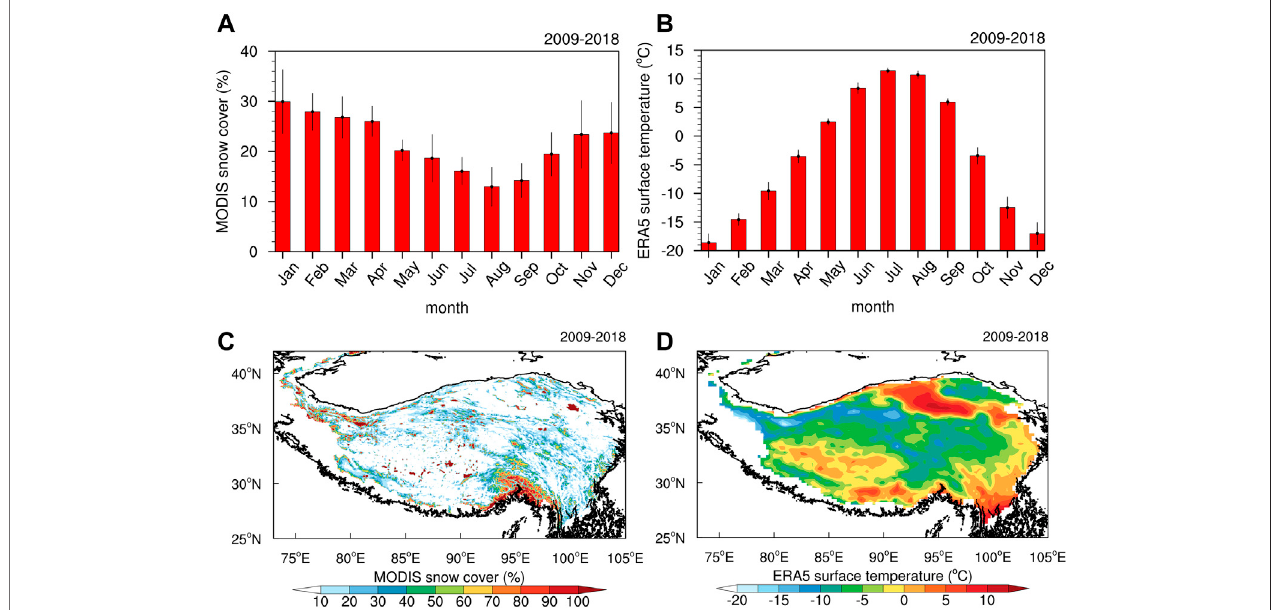
FIGURE 5 | (A) Monthly snow cover (units: %) and (C) spatial distributions of snow cover (units: %) over the TP for 2009 – 2018 derived from the MODIS retrievals. (B) Monthly surface temperature (units: ° C) and (D) spatial distributions of surface temperature (units: ° C) over the TP for 2009 – 2018 derived from ERA5 reanalysis datasets. The error bars represent the standard deviation of the corresponding